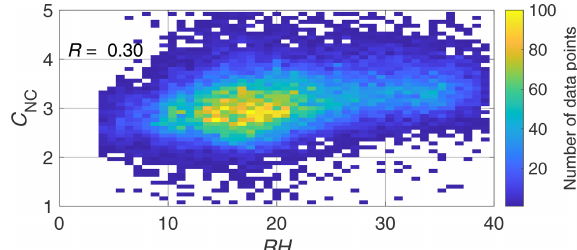
Figure 3. The dependency of the multiple-scattering correction fac- tor for non-corrected data ( C NC ) on the instrumental relative hu- midity (RH) in the MAAP. The colored grid points represent the number of data points in each grid point. There are 50 grid points in the x and y directions, so in total there are 2500 grid